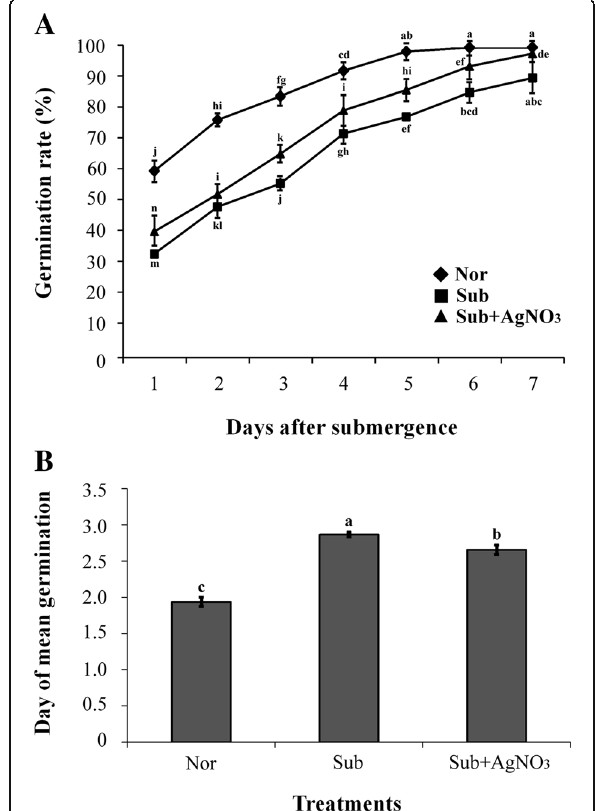
Fig. 1 The germination assay of rice seeds under submergence combined with inhibition of ethylene signaling conditions. Seeds were surface sterilized and placed on a wet filter paper under Nor, Sub, and Sub + AgNO 3 for pretreatment for 2 days and subsequently placed under Nor in a growth chamber for the germination assay. Seed germination was observed for 1, 2, 3, 4, 5, 6, and 7 days. a The germination rate of TK9 rice seeds. b The day of mean germination. The data represent the average values ± SD from 30 seedlings of each treatment obtained from three biologically independent experiments. The values with different letters are significantly different at P < 0.05, according to one-way ANOVA with post hoc Duncan ’ s